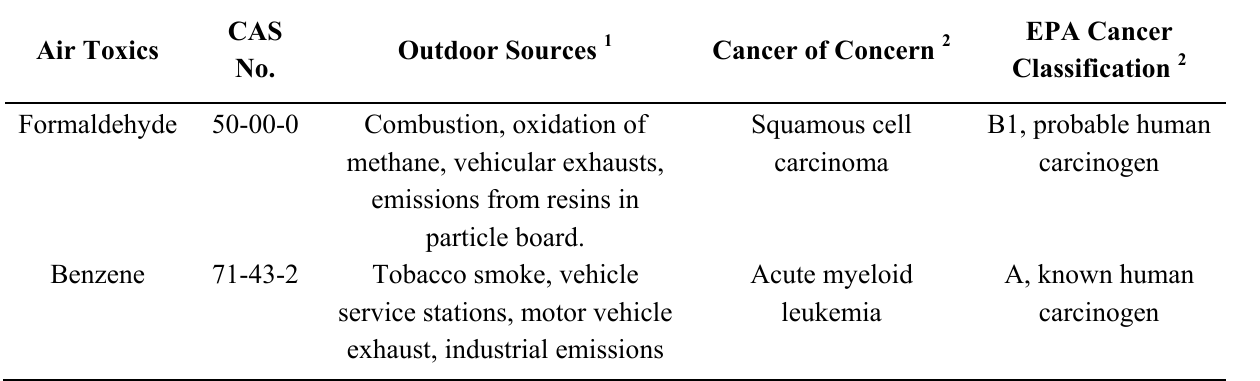
Table A3. Risk drivers in Cancer Alley and their sources, cancers of concern and cancer